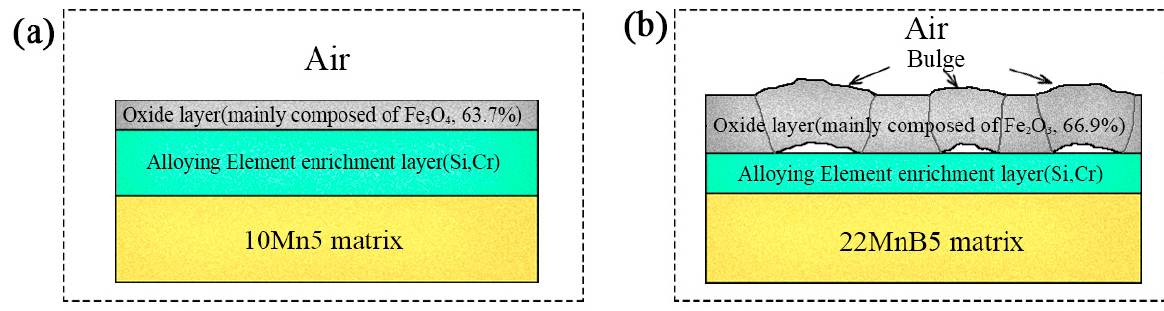
Figure 9. Oxidation model of steels at high temperature, ( a ) 10Mn5 steel, ( b ) 22MnB5 steel. The wear mechanisms of 10Mn5 and 22MnB5 steel are further verified by the com- parison of the morphology and composition of the H13 mold surface after the wear test.